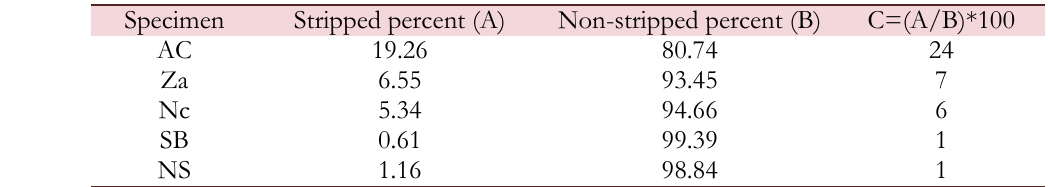
Table 4: MATLAB output for boiling water